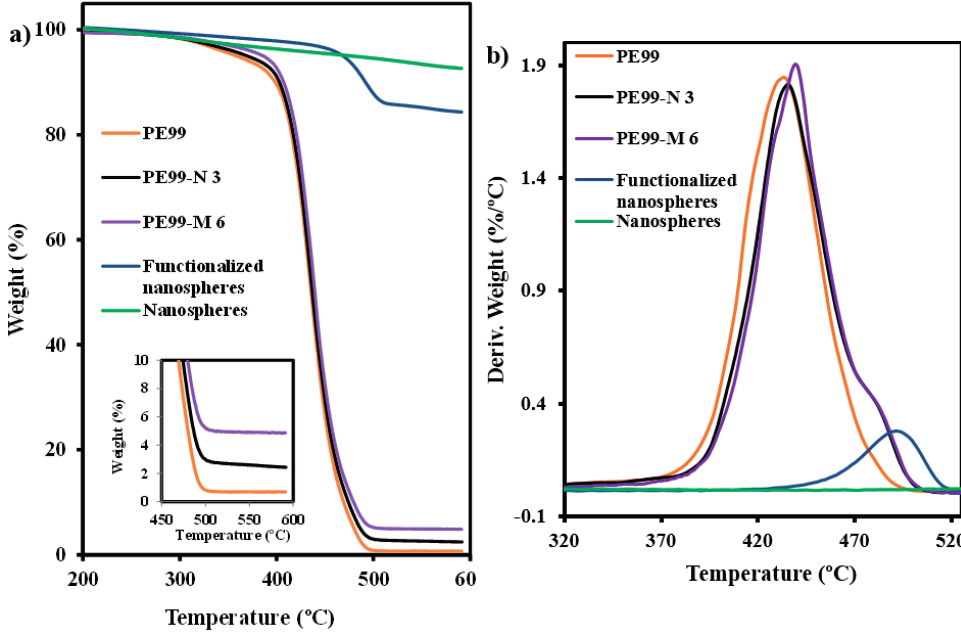
Figure 5. TGA ( a ) and DTGA ( b ) curves of silica nanospheres, functionalized silica nanospheres, and micro-molded PE99, PE99-N 3, and PE99-M 6